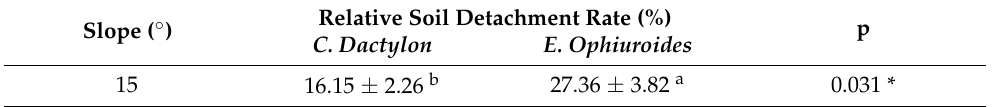
Table 6. Means ± SEs of relative soil detachment rates between C. dactylon and E. ophiuroides . Relative Soil Detachment Rate Slope ( ◦ )